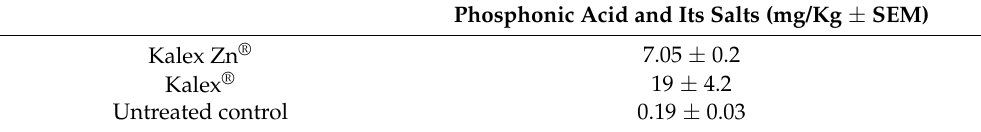
Table 3. Residues of phosphonic acid and its salts in fruits treated with Kalex Zn ® by crown spray, Kalex ® by endotherapy, and untreated control. SEM, standard error.